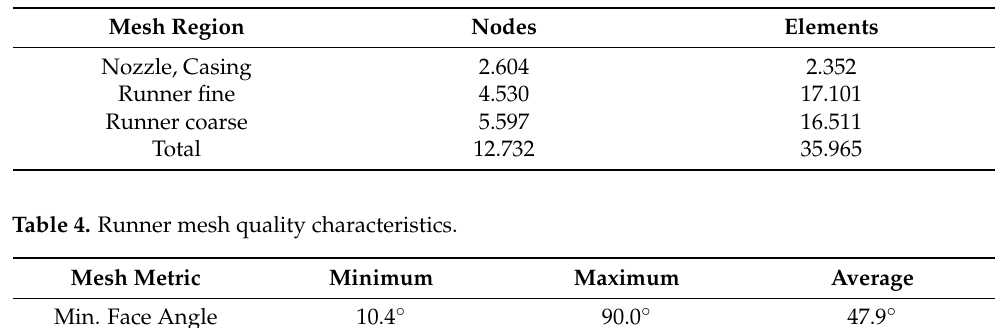
Figure 7. Detailed view of the mesh refinements: ( a ) in the internal cutout region; ( b ) on the external cutout surface. Table 3. Mesh statistics of the casing and the runner subdomains (in millions).